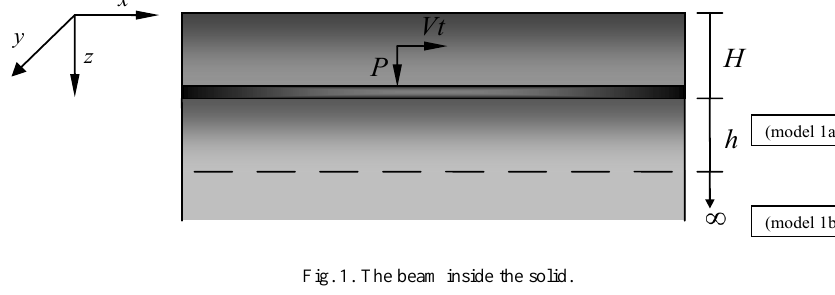
Fig. 1. The beam inside the solid.